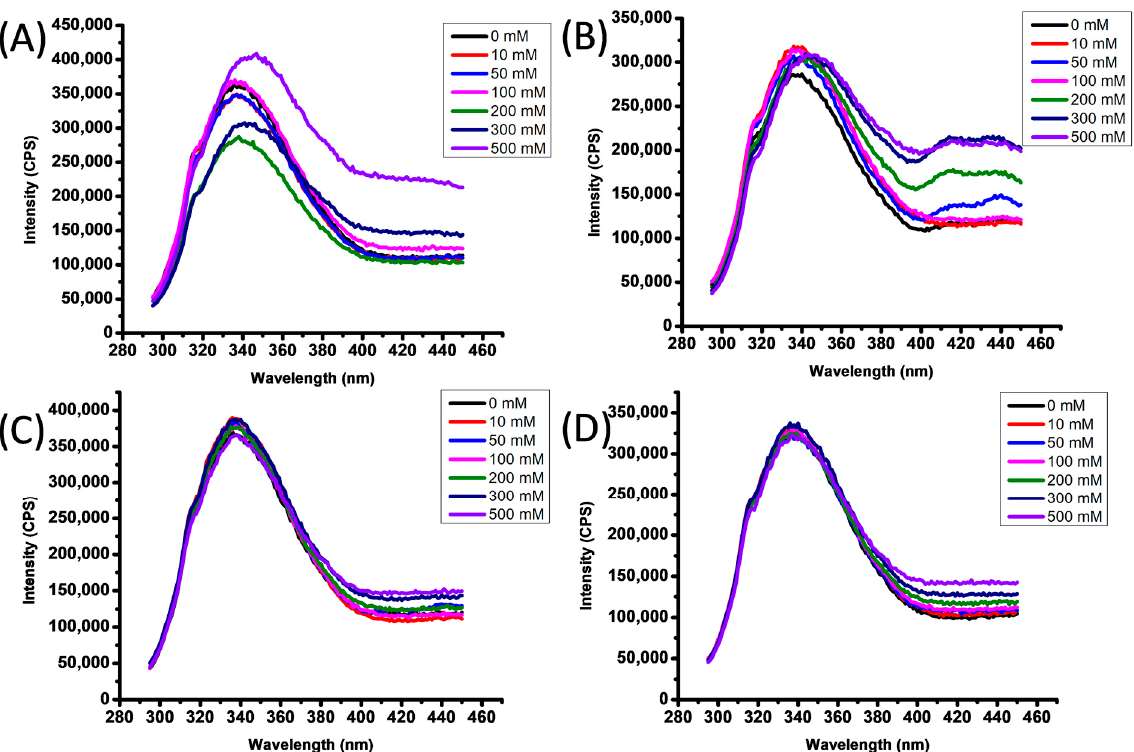
Figure 4. Laccase fluorescence emission spectra at pH 5.1 in the presence and absence of amino acid ionic liquids. In all panels, laccase concentration was 6.25 µM and amino acid IL concentrations are denoted in the legend. Fluorescence was measured in the presence of ( A ) TMG-Ser, ( B ) TMG-Thr, ( C ) TMG-Asp, and ( D ) TMG-Glu. Representative spectra are shown in each panel. Ionic liquid concentrations are shown in the legends .